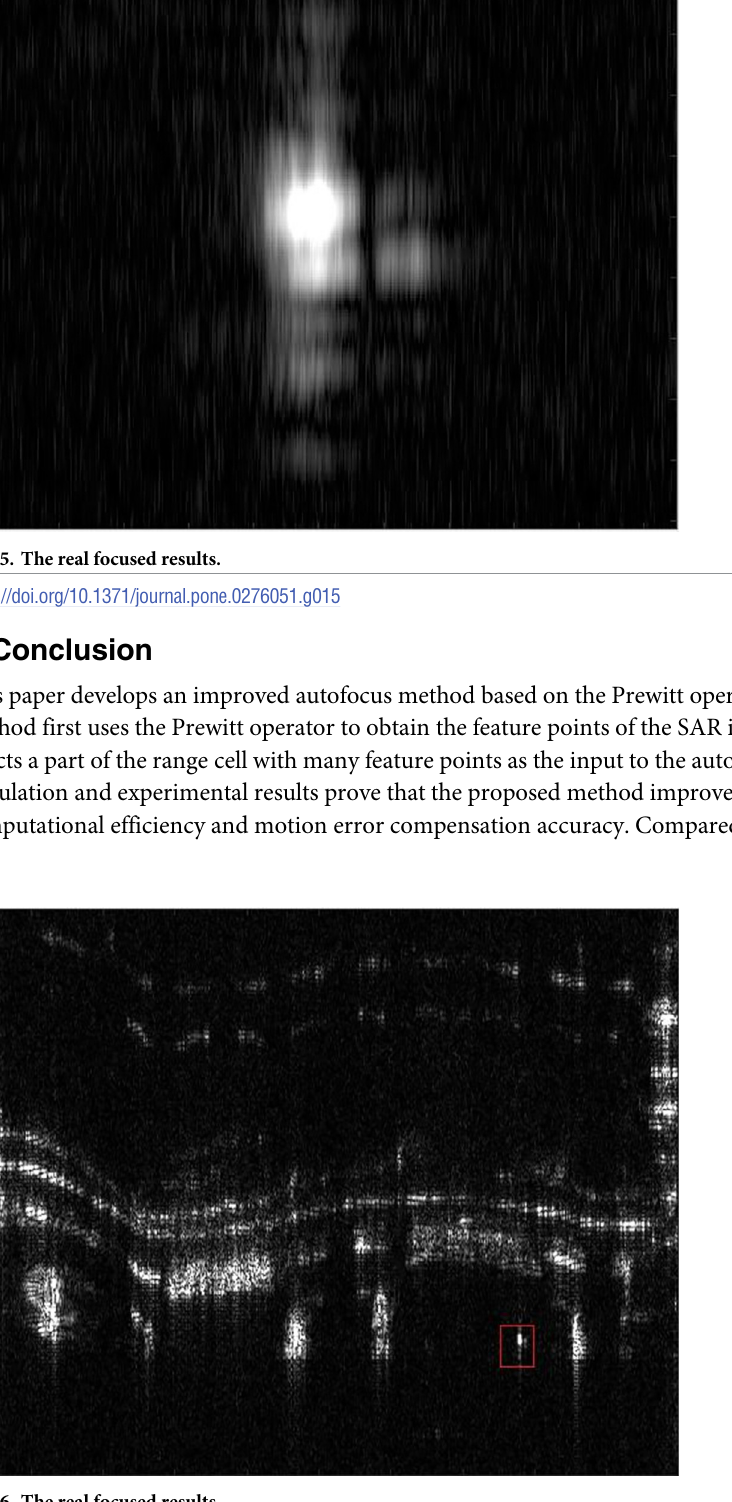
Fig 16. The real focused